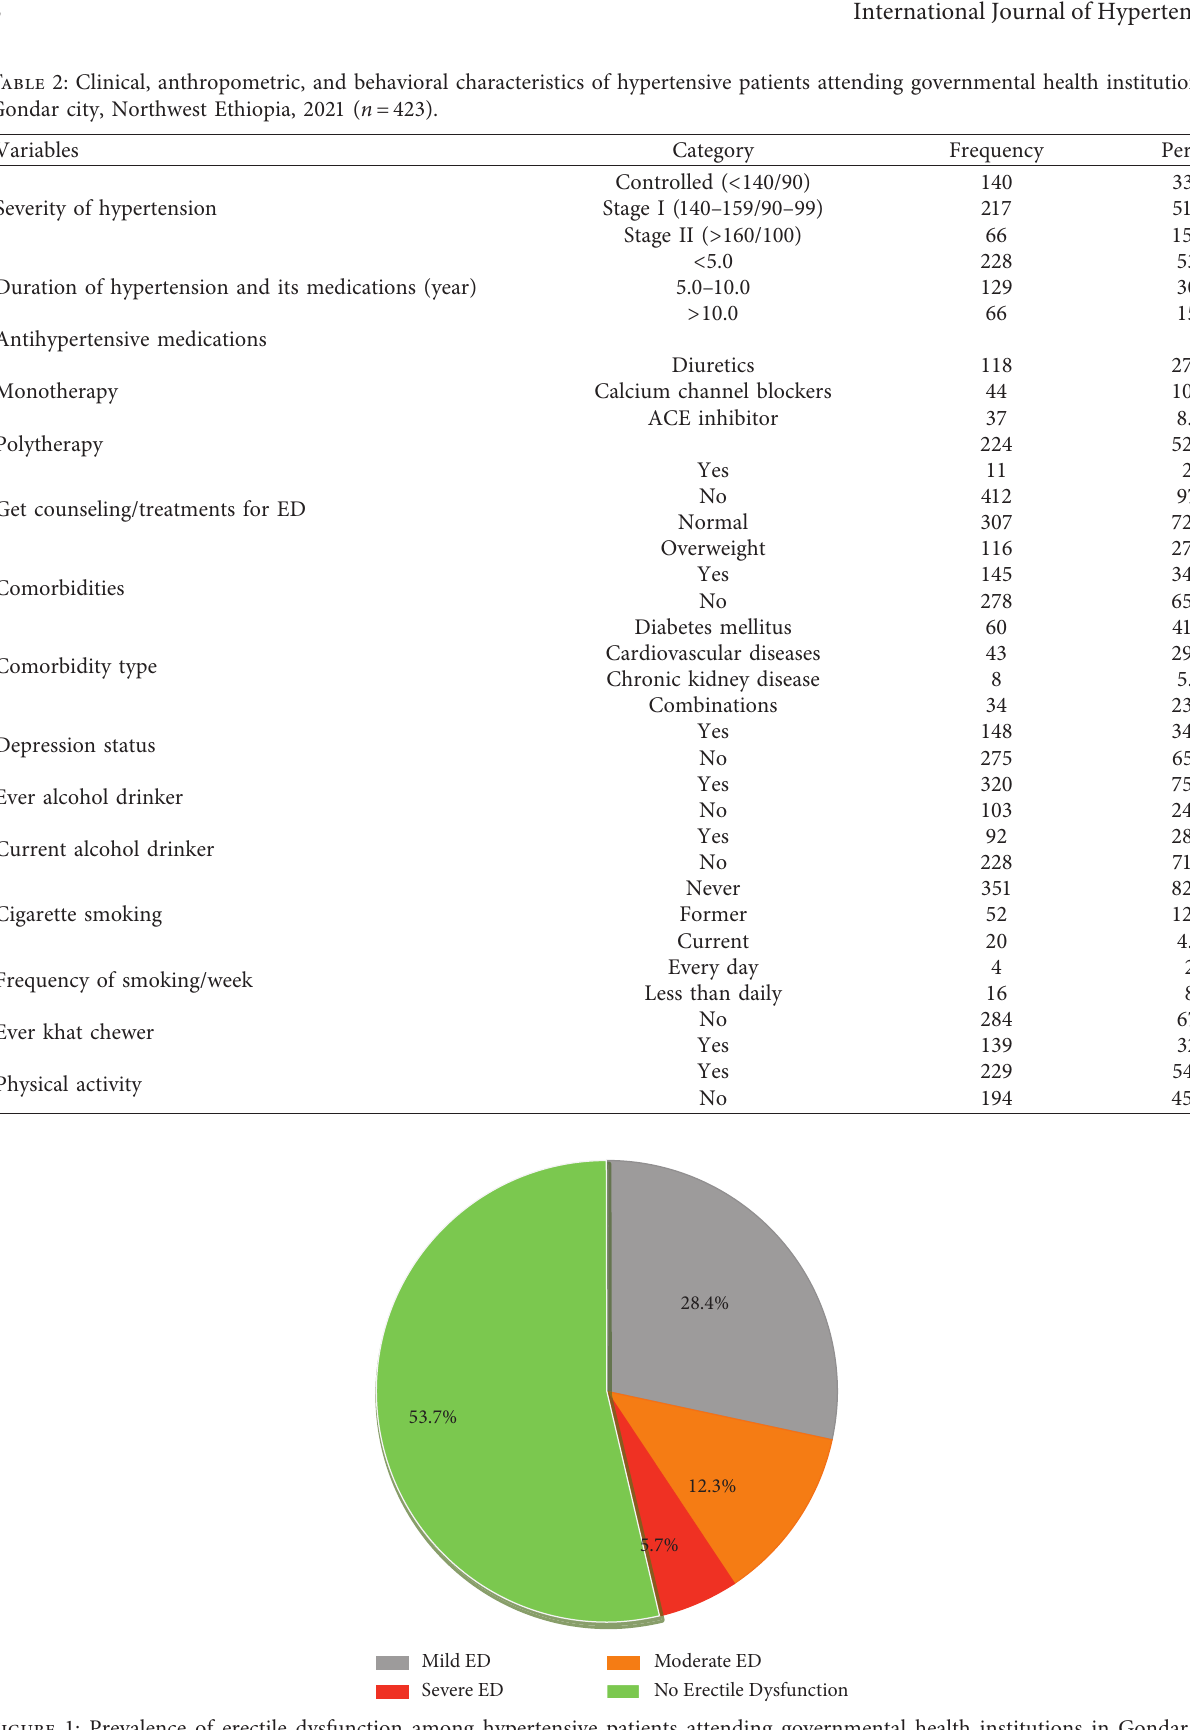
Figure 1: Prevalence of erectile dysfunction among hypertensive patients attending governmental health institutions in Gondar city, Northwest Ethiopia,